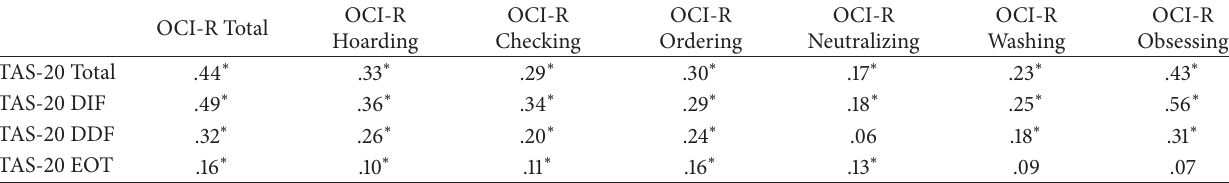
Table 2: Bivariate correlations between OCI-R subscales and TAS-20 ( 𝑛 = 425 ). OCI-R OCI-R Total Hoarding